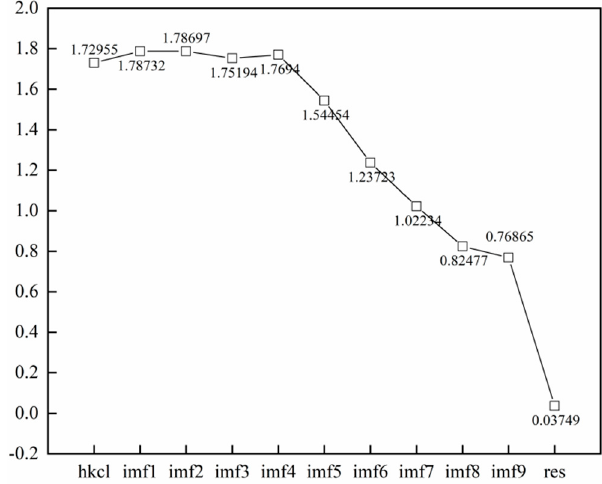
Figure 7. The PWV decomposition results for CEEMDAN. IMFn represents the nth subcomponent obtained from CEEMDAN. Res indicates the PWV trend after decomposition.